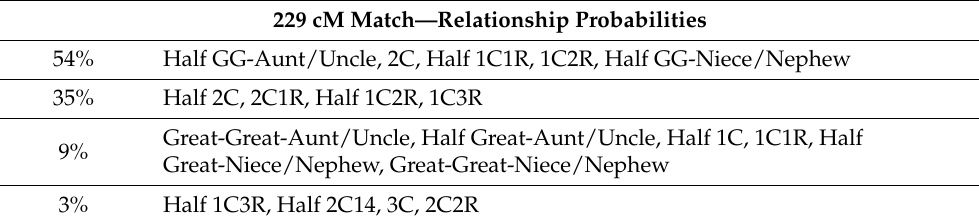
Table 2. Predicted relationship probabilities with % confidence for a 229 cM match in DNA Painter’s shared cM